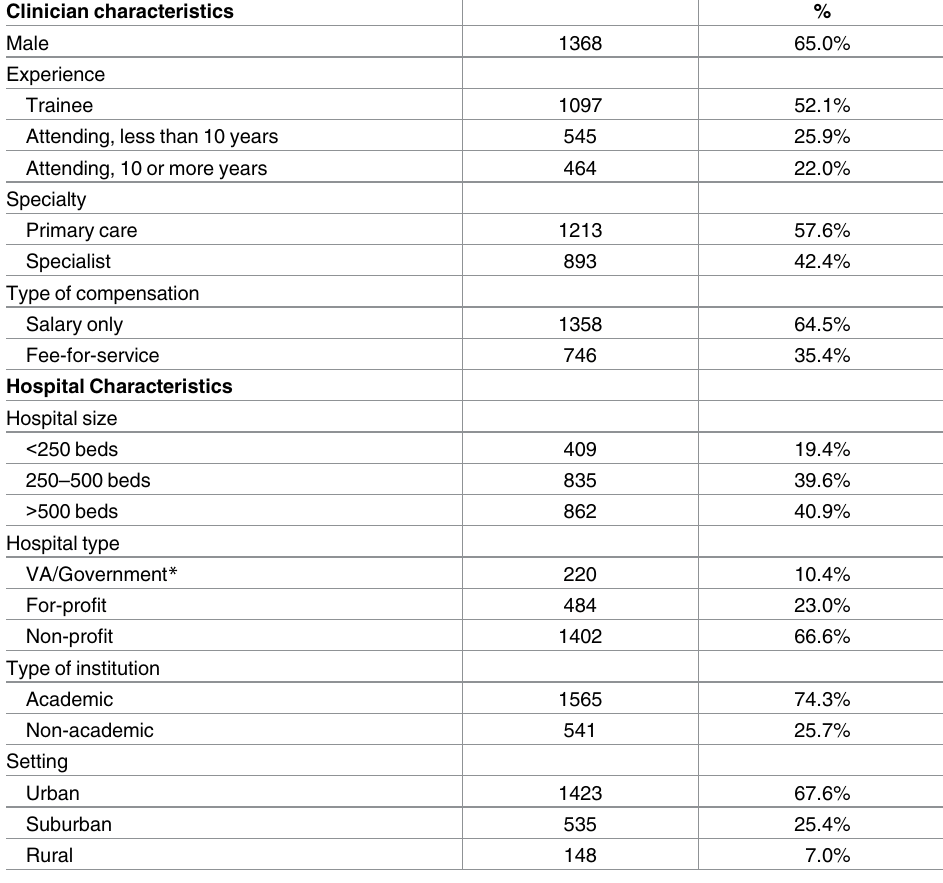
Table 1. Respondent characteristics (N =